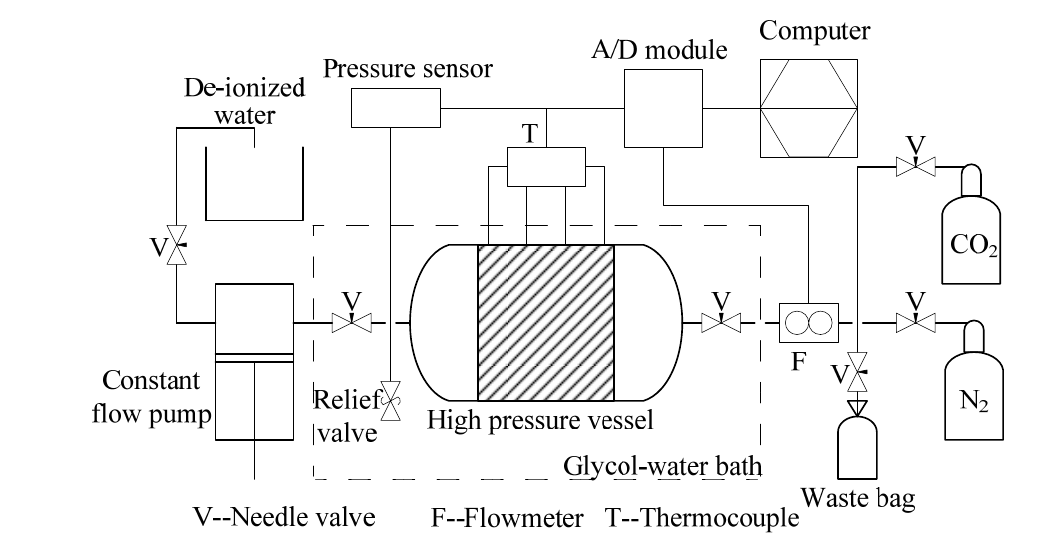
Figure 1. Scheme of the gas hydrate experimental apparatus.